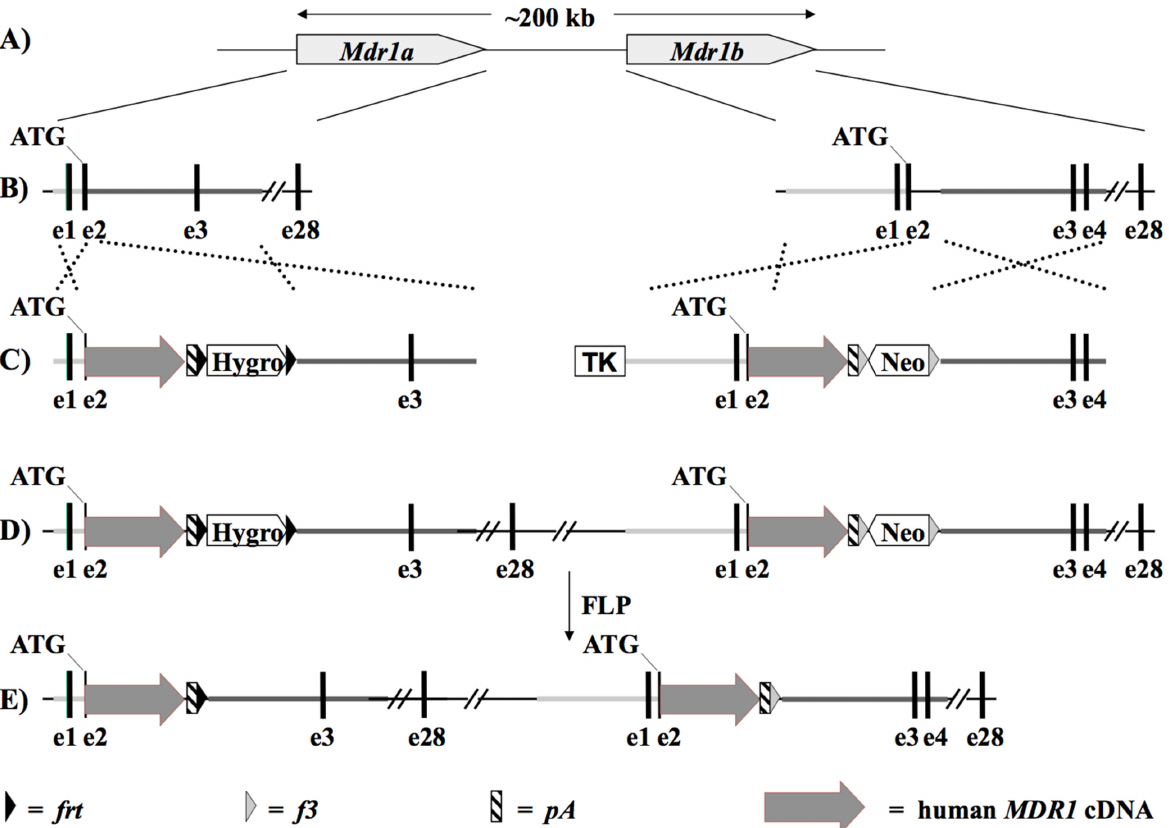
Fig 1. Stages for the development of P-gp hMDR1 mice described in different steps during which both Mdr1a and Mdr1b were knocked out from mouse DNA and replaced by human MDR1 .